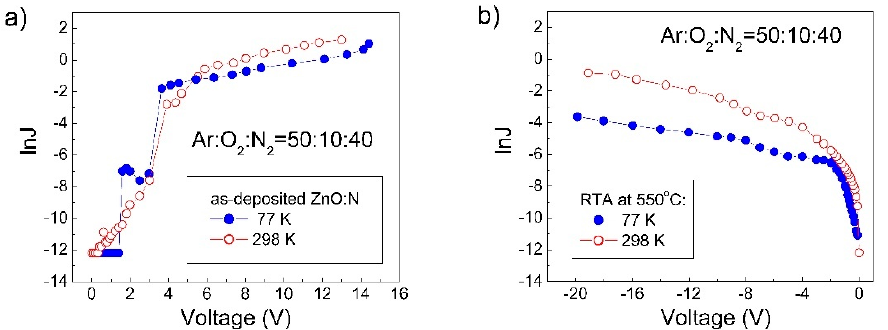
Figure 8. lnJ versus V characteristics, measured at 298 and 77 K, of MIS structures with ZnO:N films deposited at Ar:O 2 :N 2 = 50:10:40 (sample 2.1) ( a ) and after RTA at 550 °C (sample 2.3) ( b ).